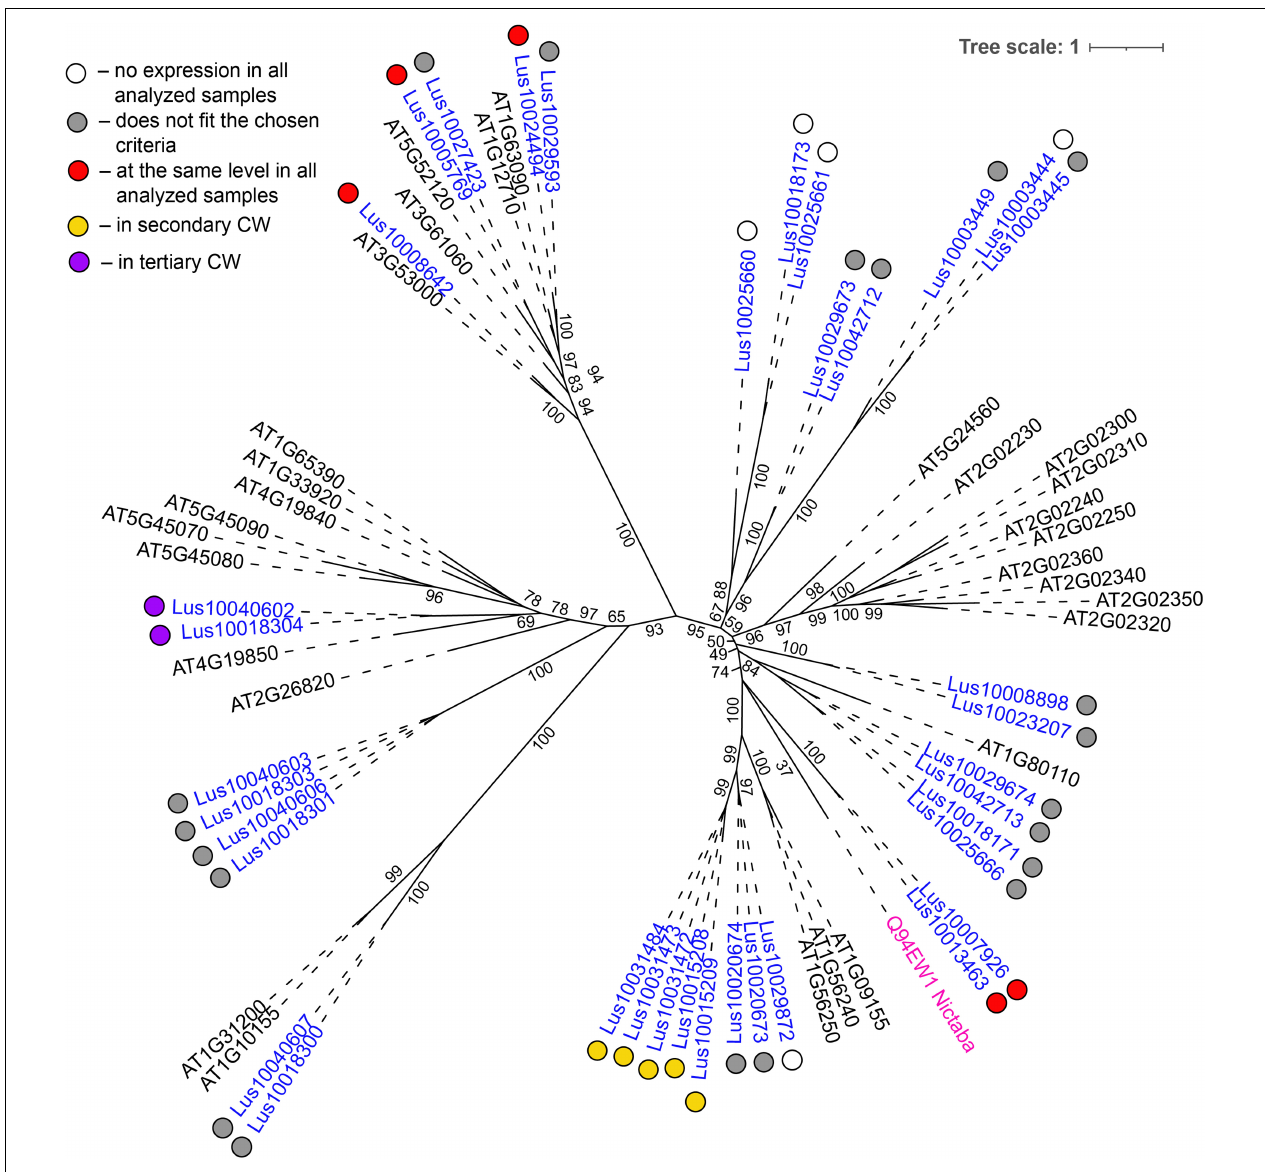
FIGURE 6 | Phylogenetic dendrogram of Nictaba (PF14299) family members of Arabidopsis thaliana and Linum usitatissimum . The A. thaliana gene names are given in black font. The L. usitatissimum gene names are given in dark blue font. Originally characterized Nictaba lectin from Nicotiana tabacum (Chen et al., 2002) is given in pink font (protein name is given according to the Uniprot database (https://www.uniprot.org/; The UniProt Consortium, 2019). The different colored dots next to L. usitatissimum gene names indicate genes with different expression patterns. The criteria used for different expression pattern identification as follow: red, the mean values of tau-score < 0.15 across all samples; yellow, DEGs upregulated in samples with secondary CW; purple dots, DEGs upregulated in samples with tertiary CW. Flax genes with red, yellow, and purple dots are listed in Tables 2 , 4 , 5 , respectively. White dots indicate genes that are not expressed in the analyzed flax samples, and gray dots indicate genes where the expression does not fit the chosen criteria (tau-score < 0.15 or DEGs) for a certain expression pattern (expression values for these genes are given in Supplementary File 3 ). Numbers indicate the ultrafast bootstrap support values for some branches. Abbreviations: DEGs, differentially expressed genes, a pairwise comparison log 2 FC ≥ 1, padj ≥ 0.01, CW, cell